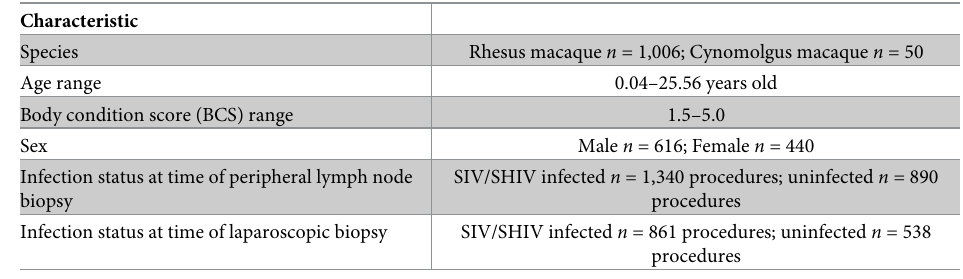
Table 1. Study animal demographics information.